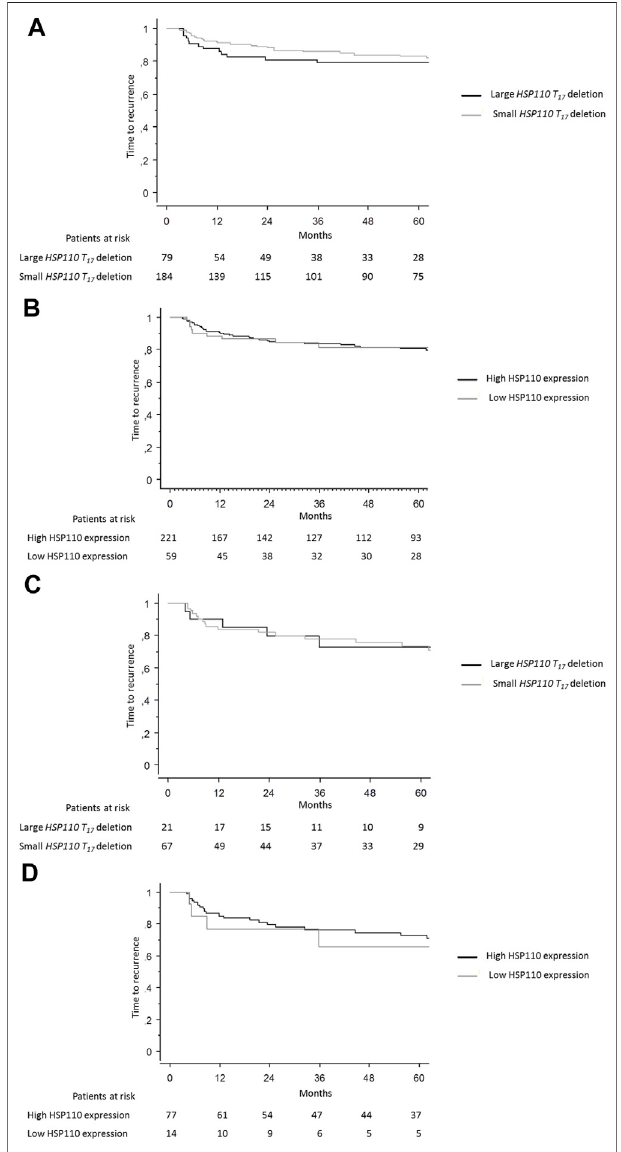
FIGURE 3 | Time to recurrence. Kaplan – Meier curves showing the time to recurrence in patients with stage II or III MSI CRC according to (A) size of HSP110 T 17 deletion and (B) HSP110 expression and time to recurrence in patients with stage II or III MSI CRC who received adjuvant chemotherapy according to (C) size of HSP110 T 17 deletion and (D) HSP110 expression.